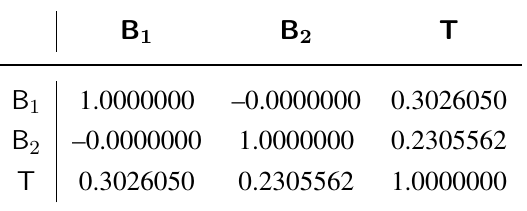
Table 3. Correlation matrix of the datasets RANKIT and RANKITMIX , respectively.